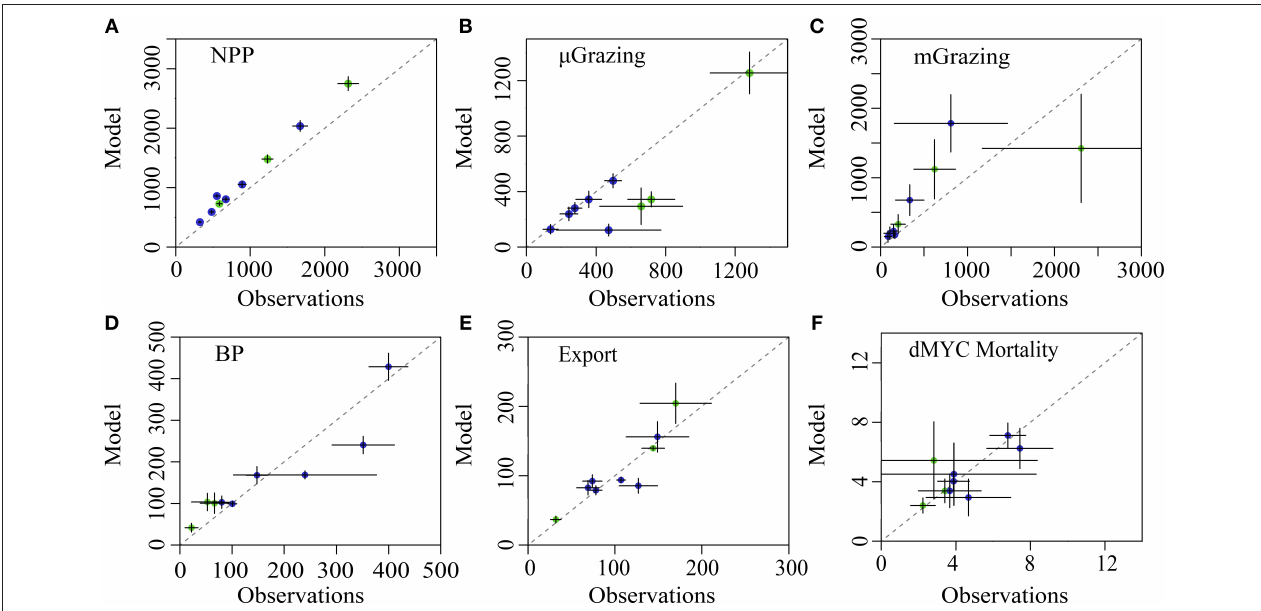
FIGURE 3 | Model-observation comparisons for selected measurements: (A) net primary productivity, (B) protistan zooplankton grazing, (C) mesozooplankton grazing, (D) epipelagic bacterial production, (E) sediment trap carbon export (@ 100m), and (F) non-vertically migrating mesopelagic nekton mortality. Cruises are denoted by color (P0704 = green, P0810 = blue). Dashed line is 1:1 and error bars show 1 SD of